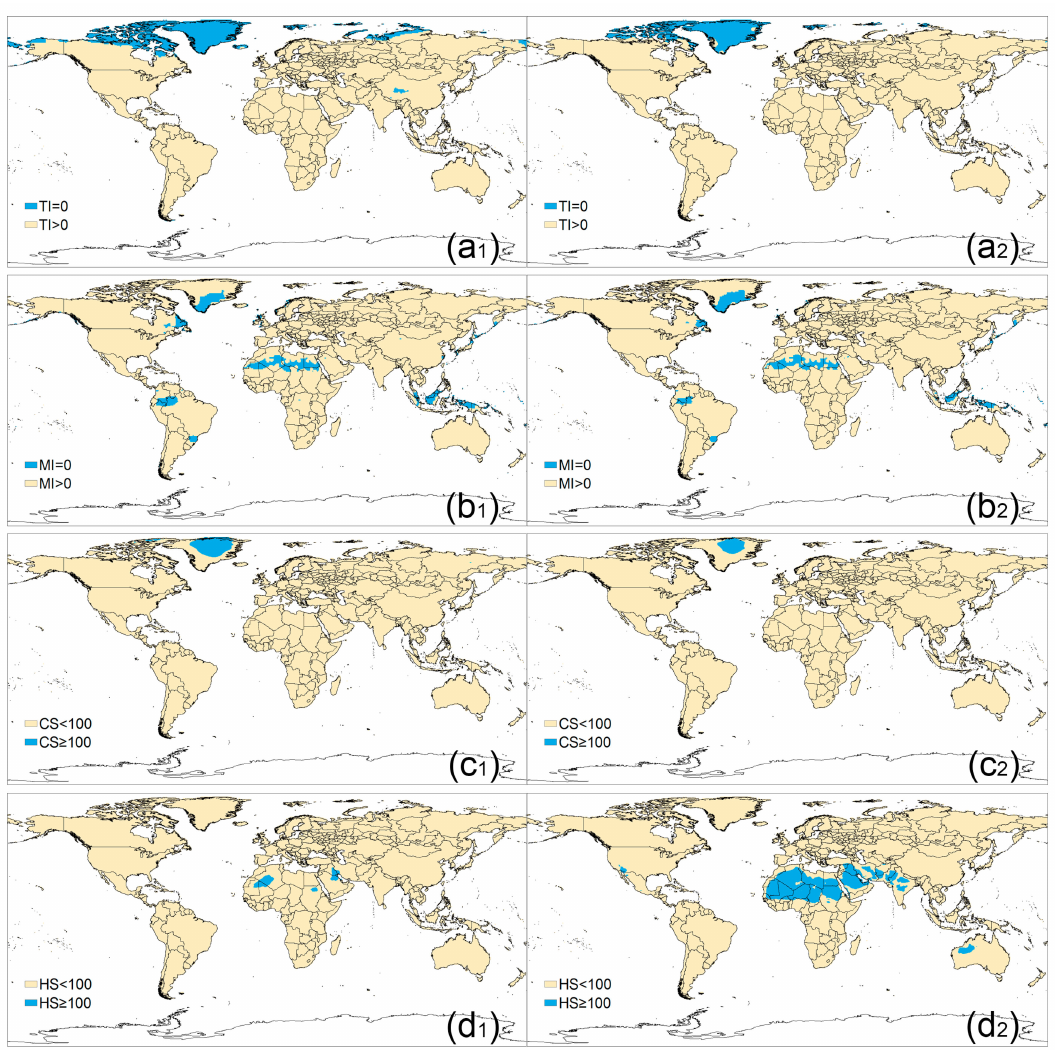
Figure 7. Limiting distribution maps for four di ff erent conditions. ( a ) Regions in which the temperature index (TI) will be unsuitable for survival are shown in blue. ( b ) Regions in which the moisture index (MI) will be unsuitable for survival are shown in blue. ( c ) Regions in which cold stress (CS) will be unsuitable for survival are shown in blue. ( d ) Regions in which heat stress (HS) will be unsuitable for survival are shown in blue. Subscript (1) indicates historical climatic conditions and subscript (2) indicates future climatic